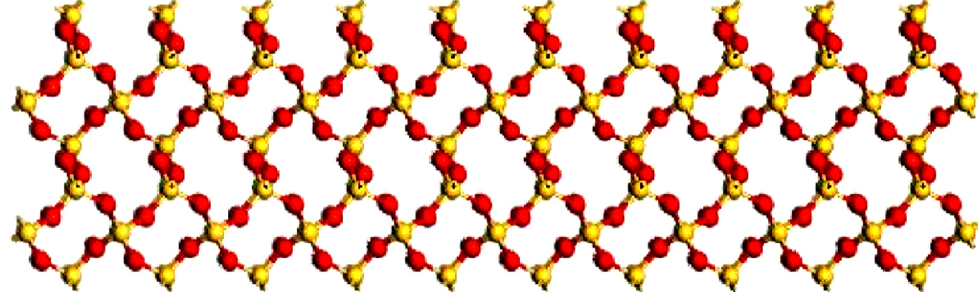
Figure 3. Schematic diagram of α -quartz structure. Red particles are oxygen atoms; yellow particles are silicon atoms.